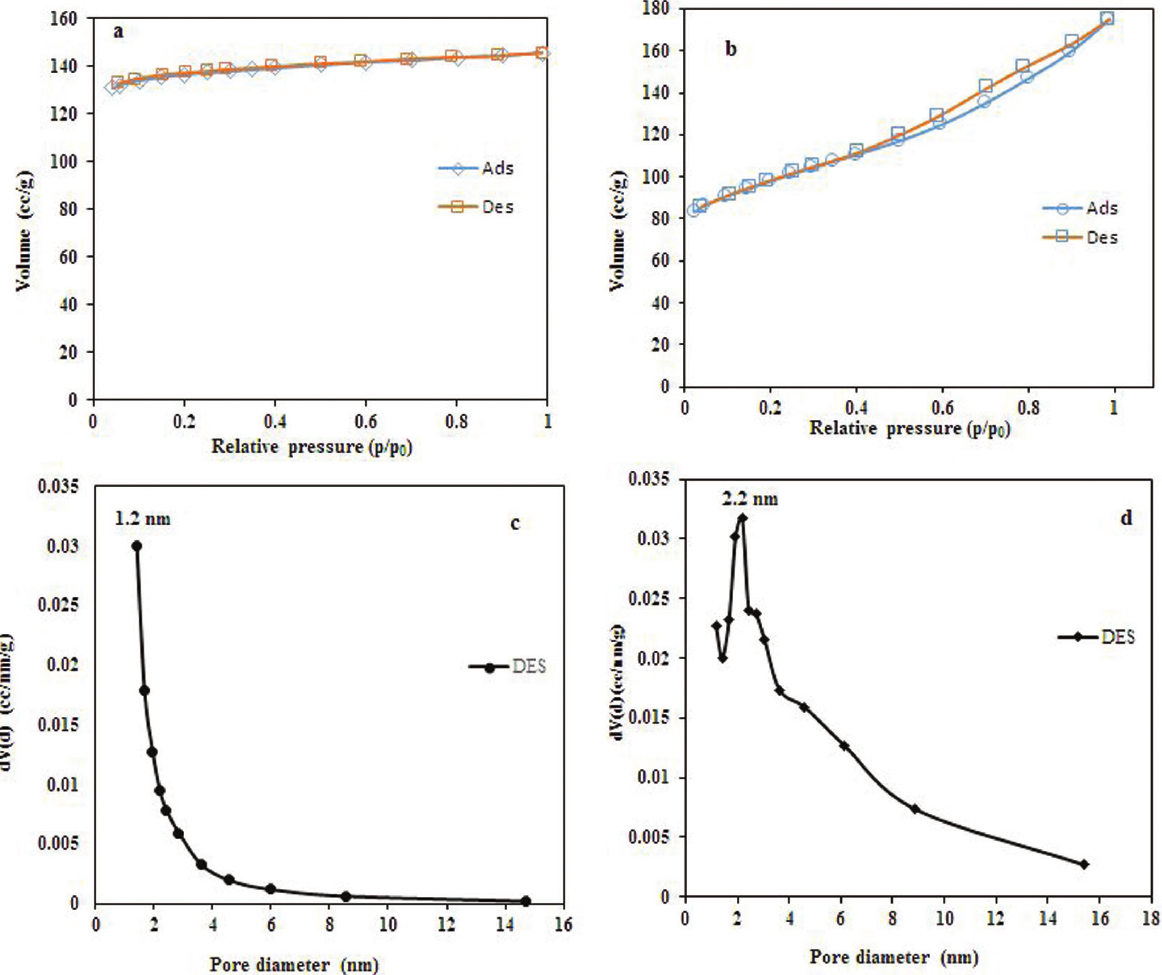
adsorption-desorption isotherm plots of (a) microporous NaY (b) hierarchical MY and pore size distribution of the (c) microporous Figure 4: N 2 NaY, (d) hierarchical